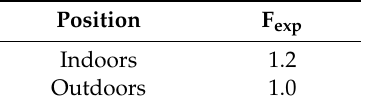
Table 2. Values for exposure location (F exp ).